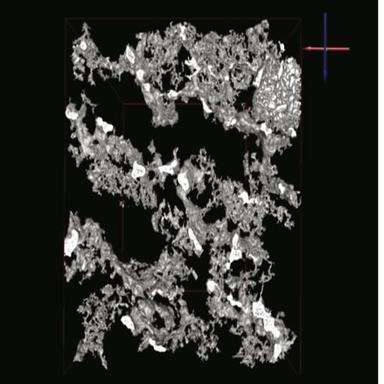
X-ray computer tomography (CT) image of extruded PCEA grade graphite illustrating an elongated pore structure oriented in the with-grain extrusion direction.